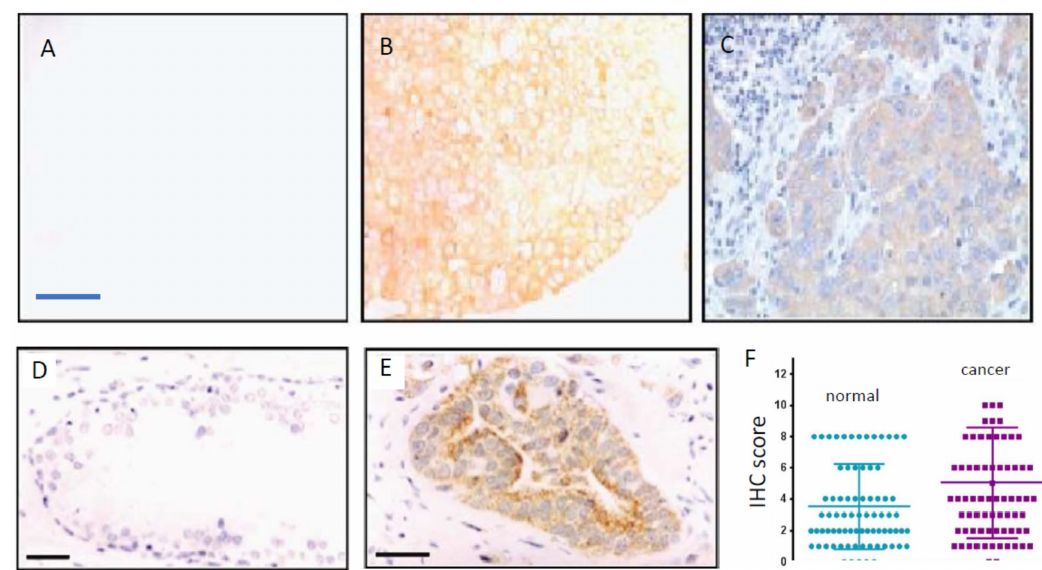
Figure 3. VGSC protein expression in breast, prostate, and colon cancers. VGSC alpha-subunit protein expression in human cancer biopsy tissue sections was determined by immunohistochemistry (IHC). ( A – C ) Typical immunostaining of human breast tissue with nNav1.5-specific polyclonal antibody (NESOpAb). Little staining was detected in normal human breast tissue, as illustrated in ( A ), whereas strong heterogeneous staining was detected in the corresponding image from breast cancer ( B ). Sections were also counterstained with haemotoxylin to confirm tissue integrity ( C ). Scale bar, shown in ( A ) is 50 µ m and is applicable also to ( B ) and ( C ). ( D , E ) Typical staining of human prostate tissue sections exhibiting morphological features of low-grade prostatic intraepithelial neoplasia (PIN) ( D ), and high-grade PIN ( E ). A pan-VGSC alpha-subunit antibody was used. Sections were also counterstained with haemotoxylin to confirm tissue integrity. Scale bar, 50 µ m is applicable to ( D ) and ( E ). ( F ) Quantitative data showing significantly higher level of Nav1.5 IHC staining of colon cancer compared with matched normal tissue ( p < 0.001; n = 78). Modified from [9] ( A – C ); [16] ( D , E ); and [42] ( F